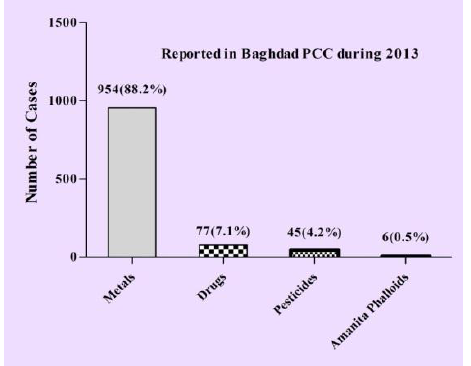
Figure (7): Distribution of poisoning cases reported in Baghdad PCC during 2013 according to the class of the poisoning agent.